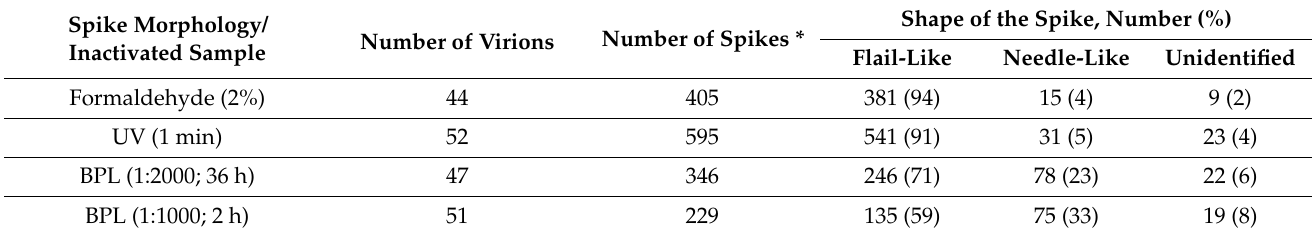
Table 2. Morphology of S-spikes at the surface of inactivated SARS-CoV-2 virions.